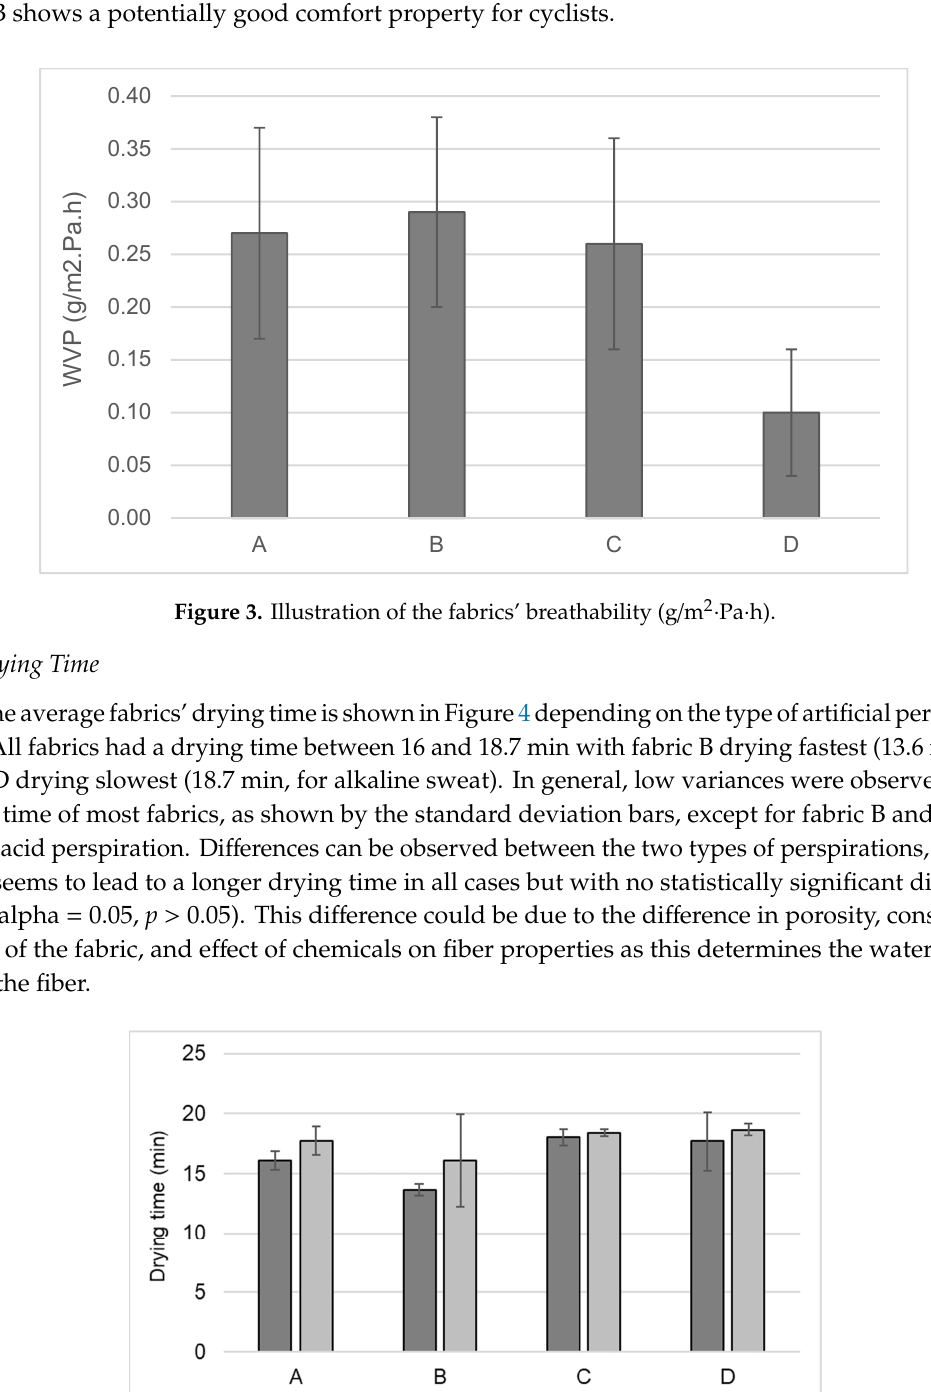
Figure 4. Drying time (100%) of the fabrics with alkaline and acid artificial perspiration.